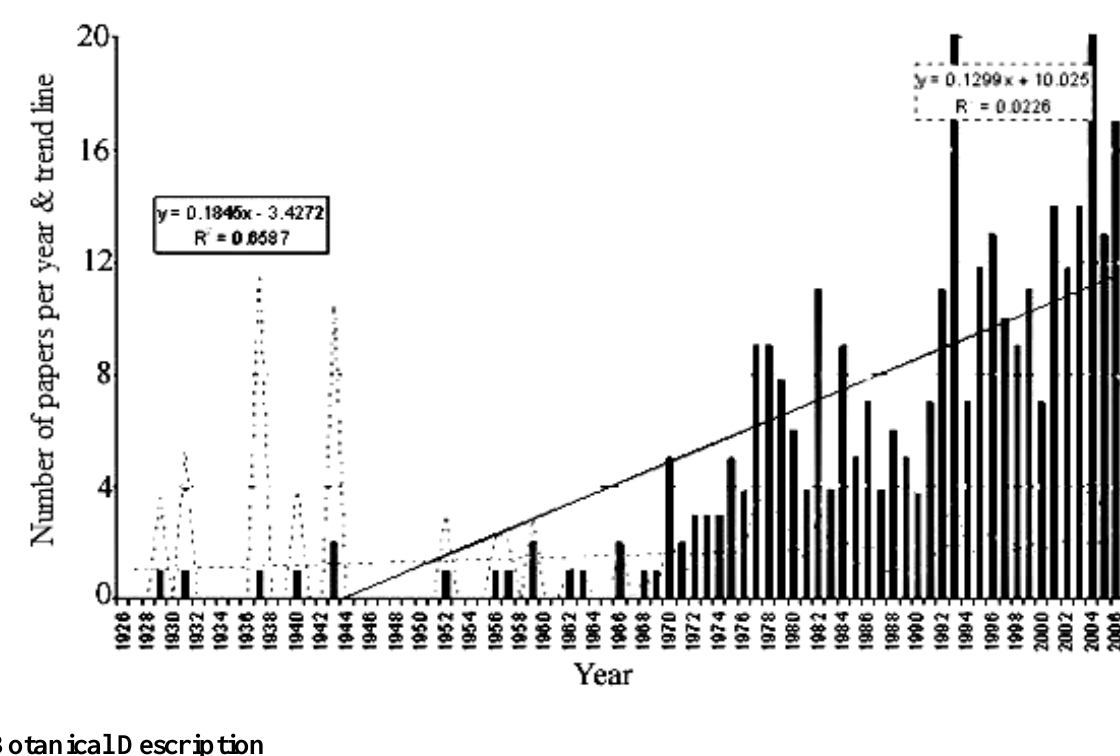
Figure 1. Popularity of Ipomea hederacea over time